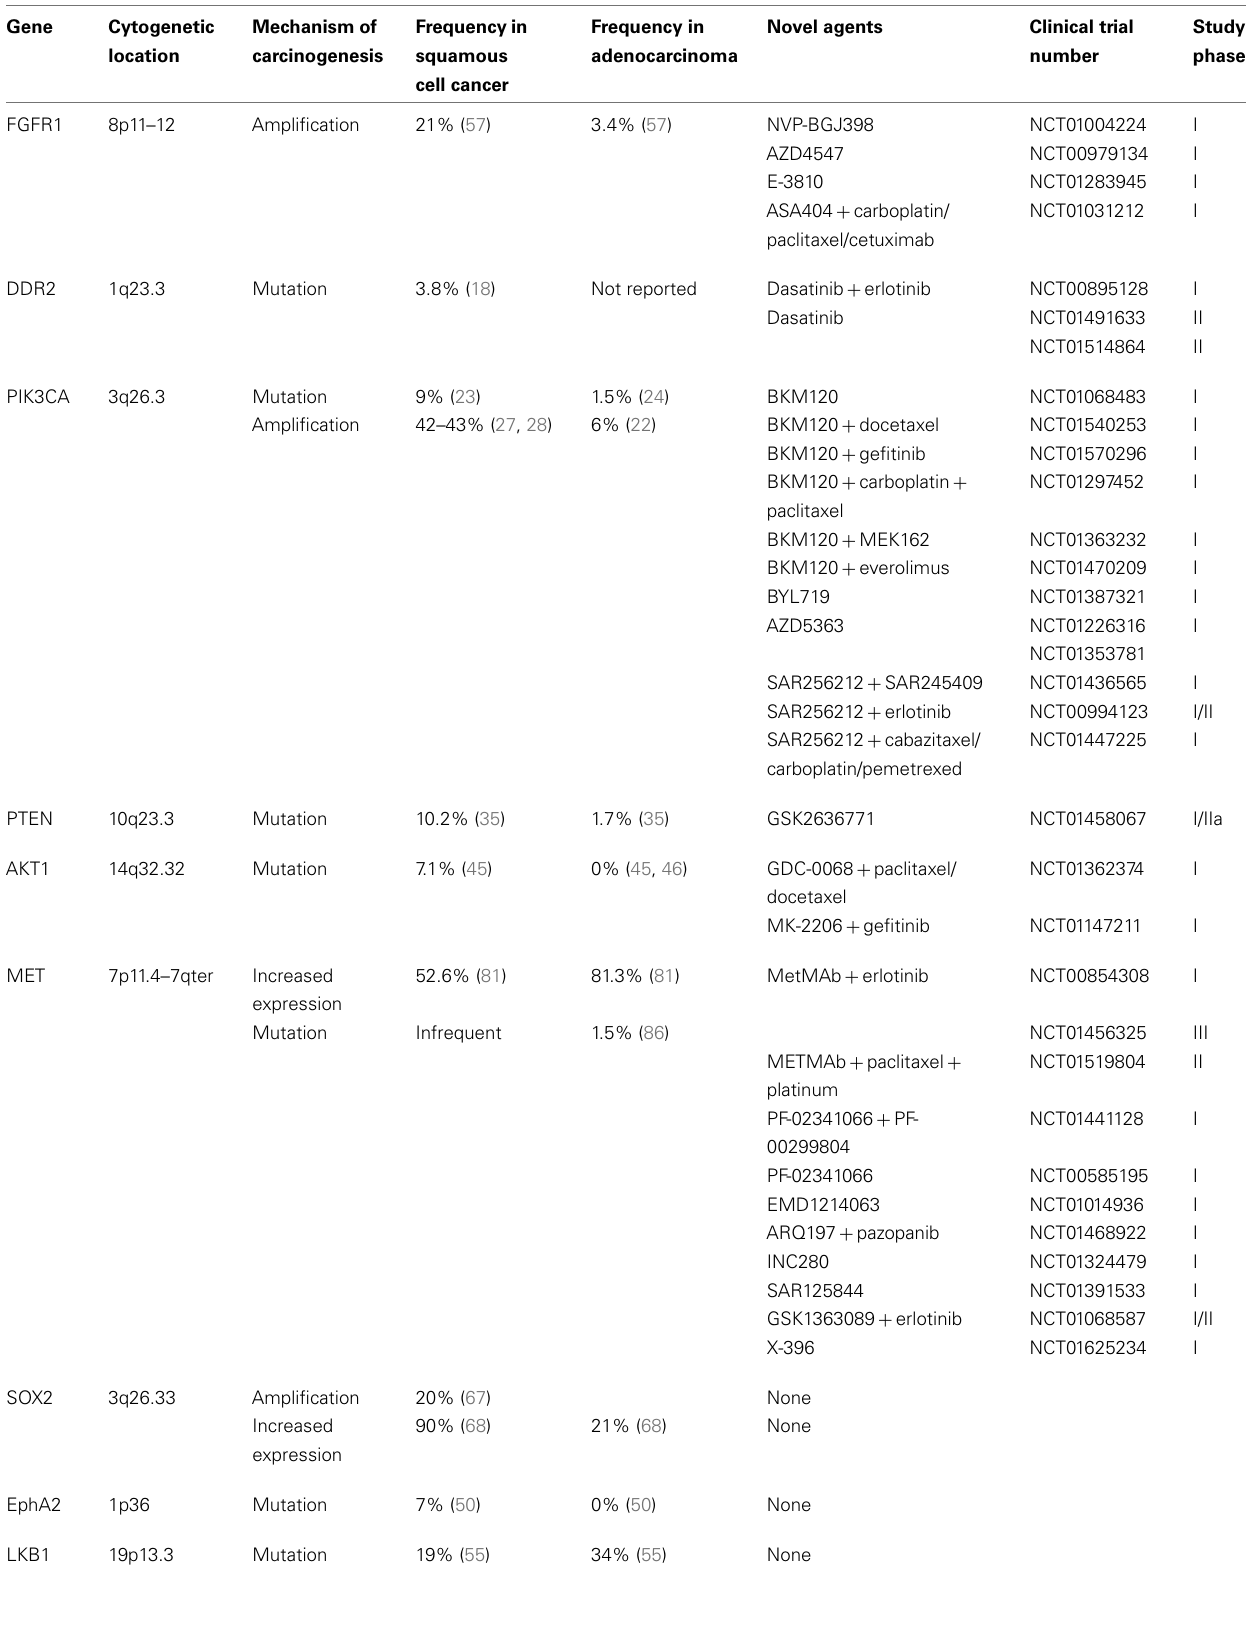
Table 1 |Targetable genes and ongoing clinical trials in squamous cell carcinoma of the lung. Gene Cytogenetic